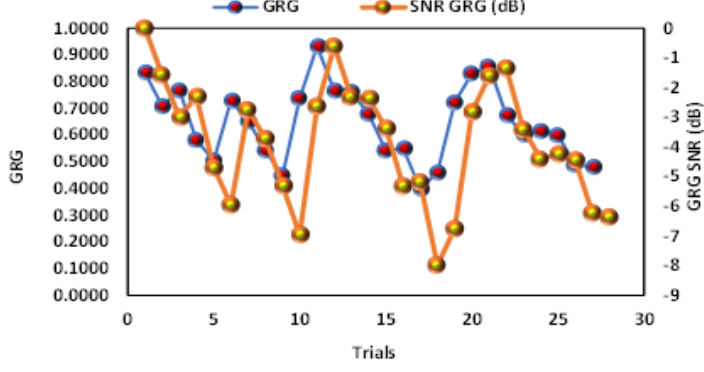
Figure 18. Plot of GRG versus SNRs.